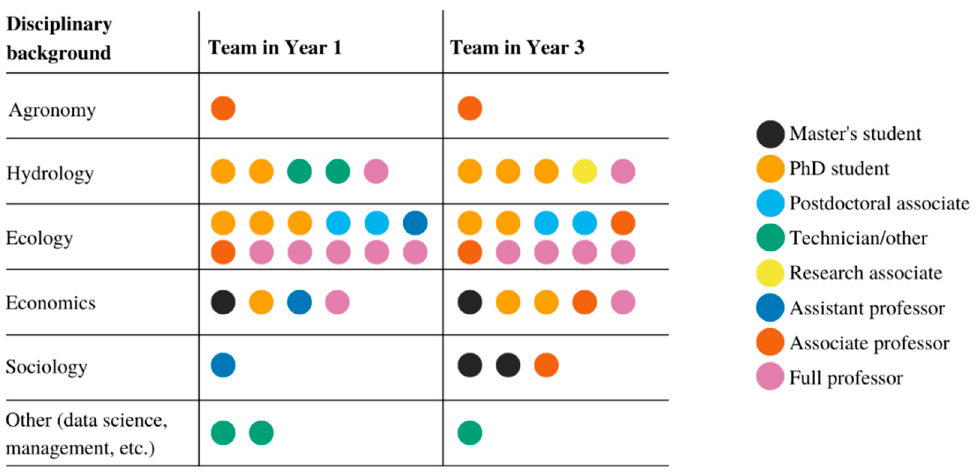
Figure 1. Distribution of CNH Lakes team members’ backgrounds and career stages.